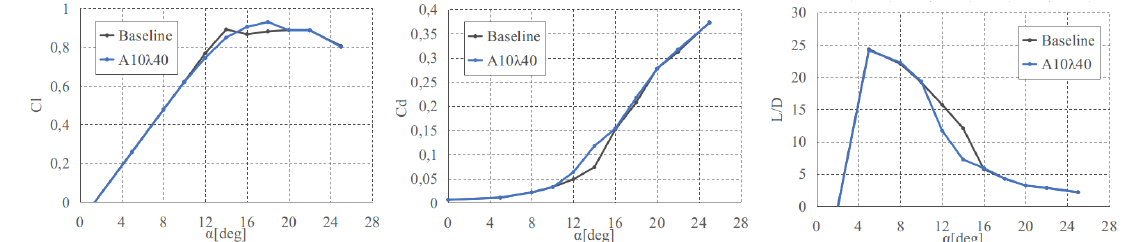
Figure 17. Lift and drag coefficient and aerodynamic efficiency for baseline and A 10 λ 40 configuration